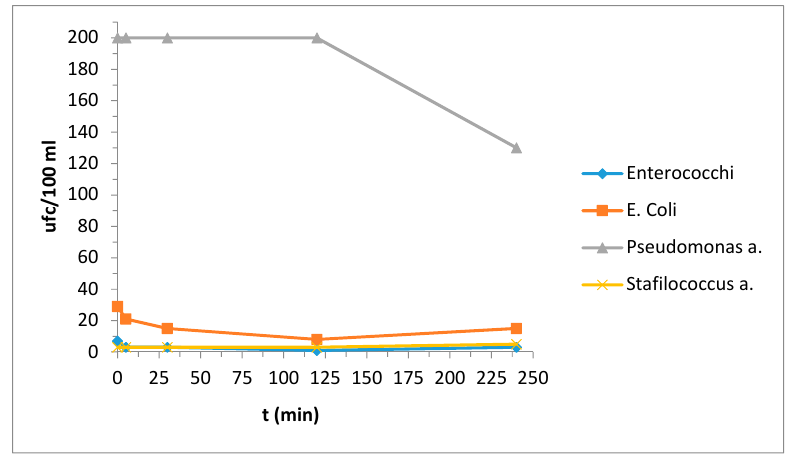
Figure 4. Evaluation of the concentration of the bacterial strains as a function of time.